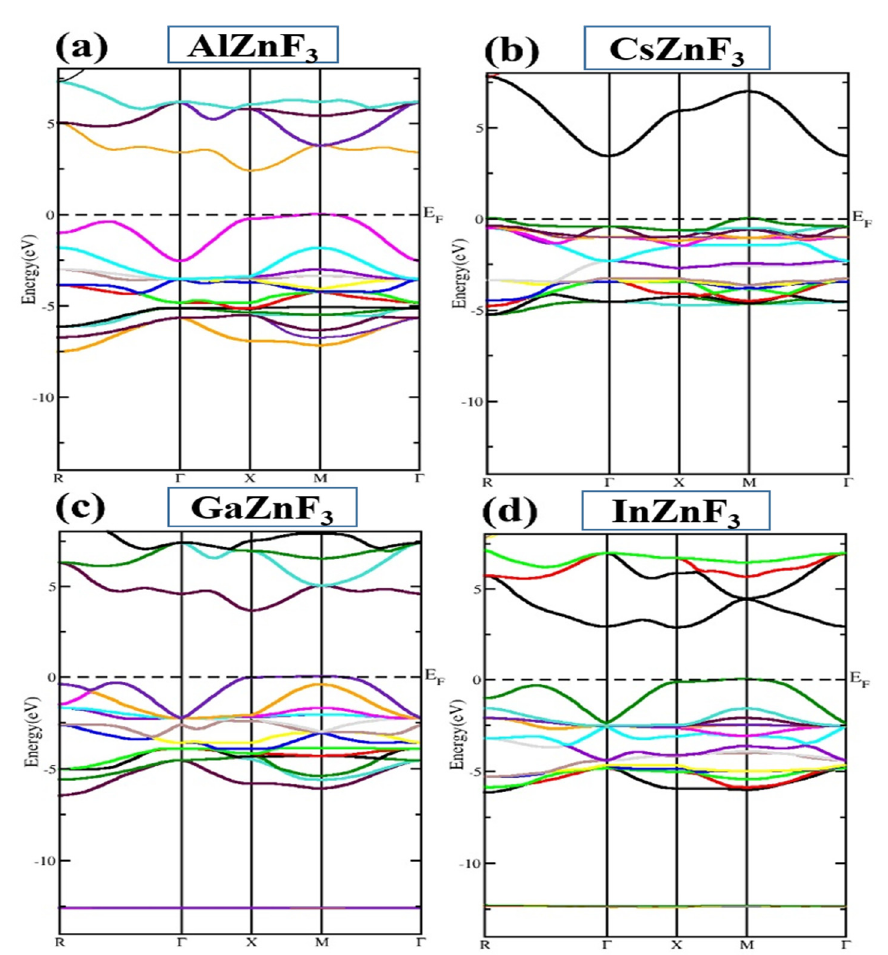
Figure 3. The calculated band structure of XZnF 3 (X = Al, Cs, Ga, In). Different colors depict the various atomic states.